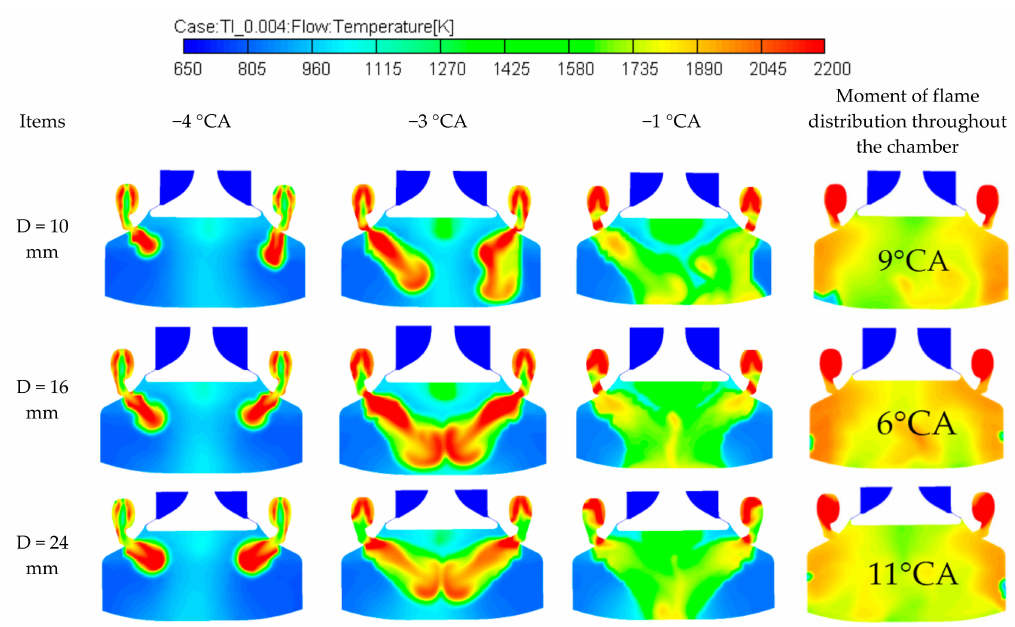
Figure 9. Temperature distribution in the combustion chamber.